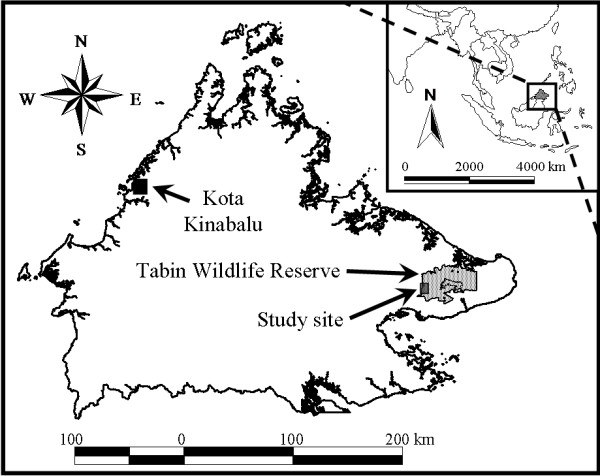
Tabin Wildlife Reserve and the study site in southeast Sabah, Malaysia.